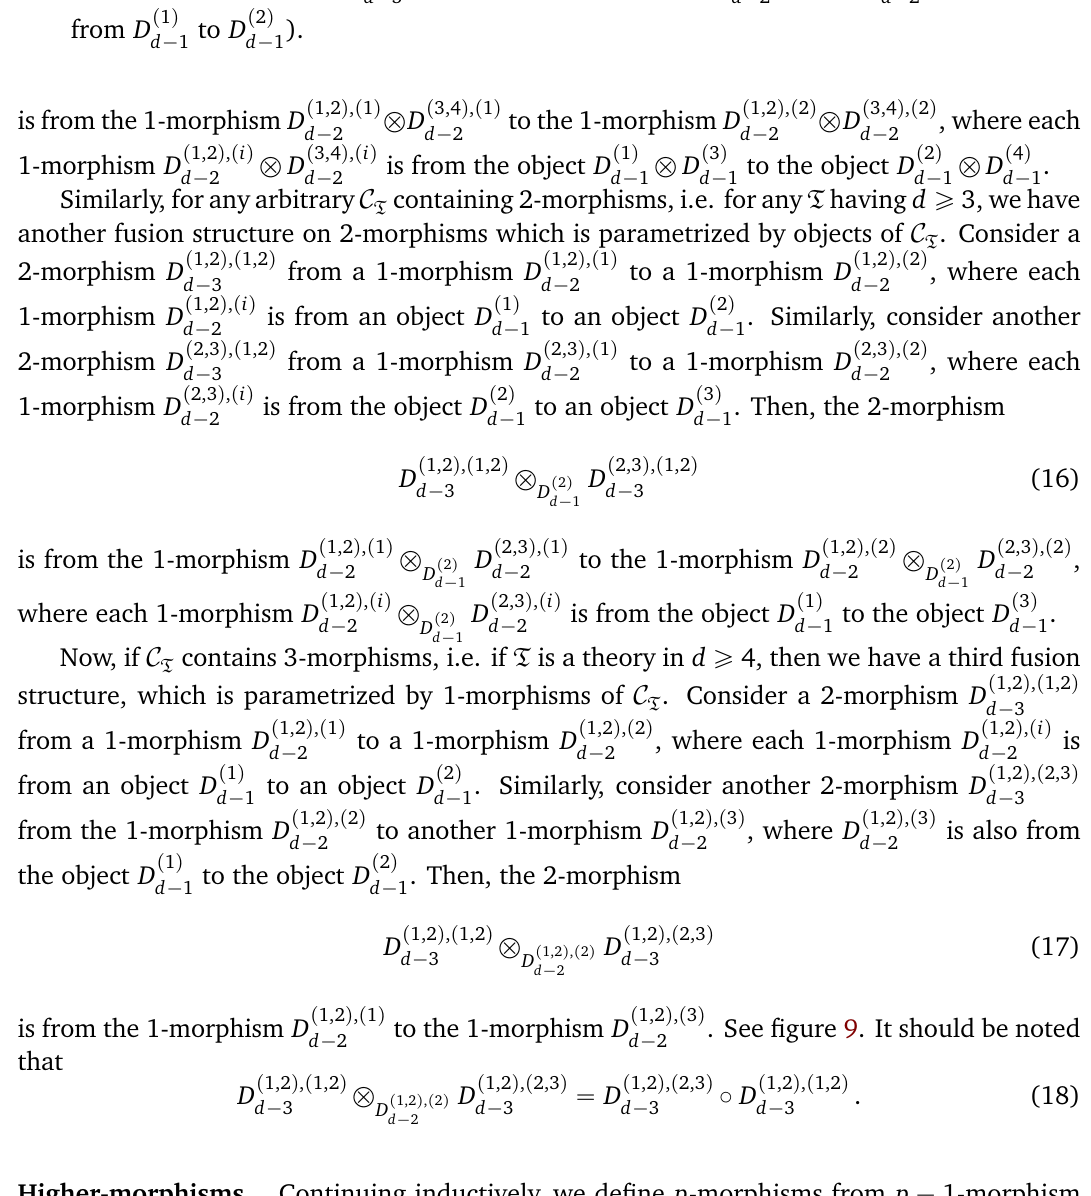
and D p 1,2 q , p 2 q (both d ´ 2 d ´ 2